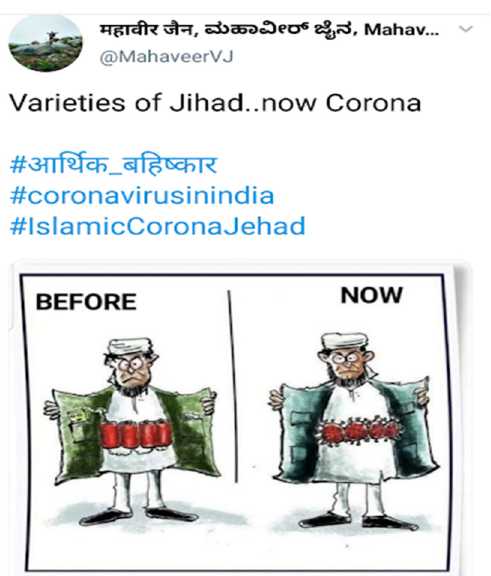
Figure 17. Meme shared by Hindu nationalist supporters promoting idea of “corona jihad”.